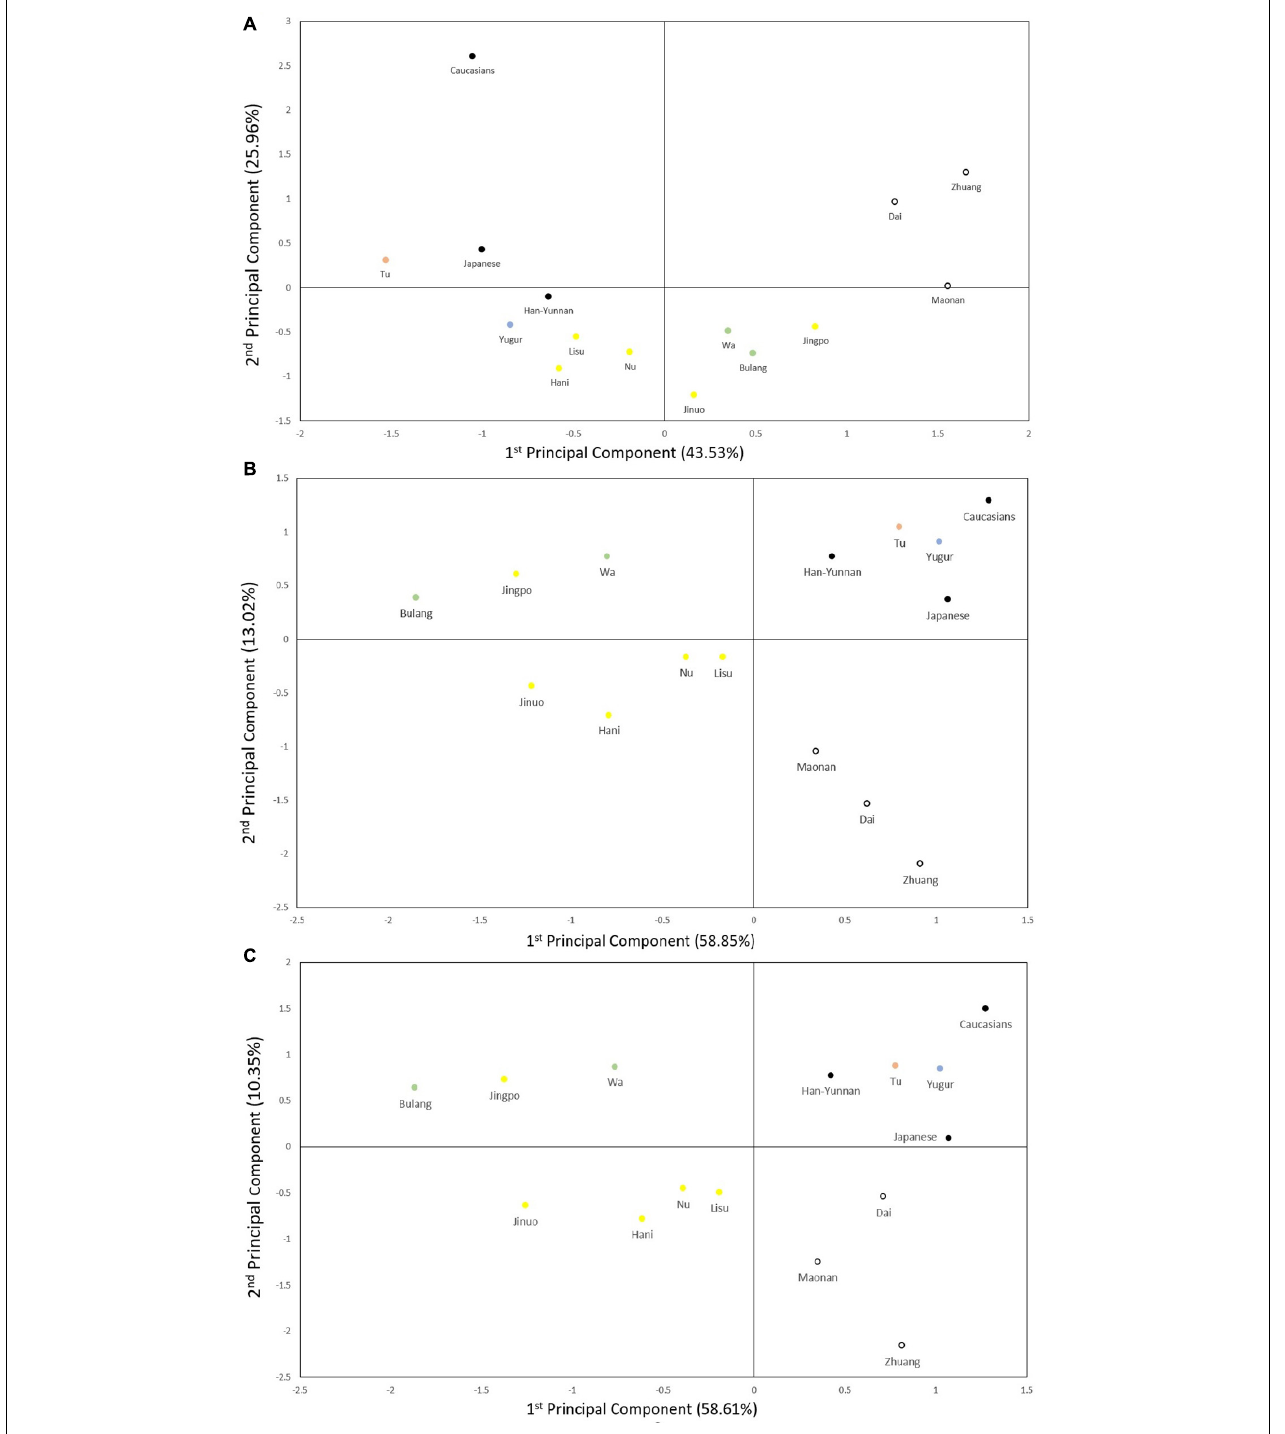
FIGURE 4 | Principal component analysis (PCA). (A) PCA based on five POALIN allele frequencies. Contributions of the first and second components were 43.53% and 25.96%, respectively. (B) PCA based on HLA-DRB1 allele frequencies. Contributions of first and second components were 58.85% and 13.02%. (C) PCA based on the DRB1/AluDRB1 haplotype frequencies. Contributions of first and second components were 58.61% and 10.35%. The colored dots represent the ancient tribe, language family and subfamily for each population listed in Table 1 . Yellow represent Di-Qiang, Sino-Tibetan, Tibeto-Burman. Green represent Baipu, Austo-Asiatic, Mon-Khmer. White represent Baiyue, Sino-Tibetan, Daic. Orange represent Mongolian, Altaic, Mongolian. Blue represent Mongolian, Altaic, Tujue.